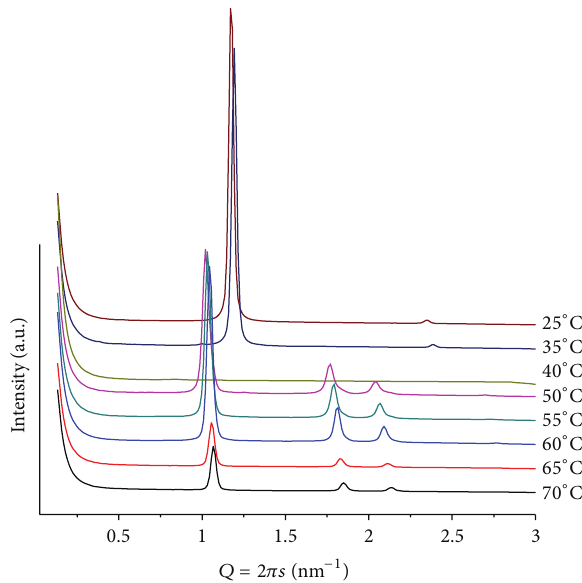
Figure 8: SAXS patterns at different temperatures for POPE/ ANHQ, mr = 50 and pH = 4 .